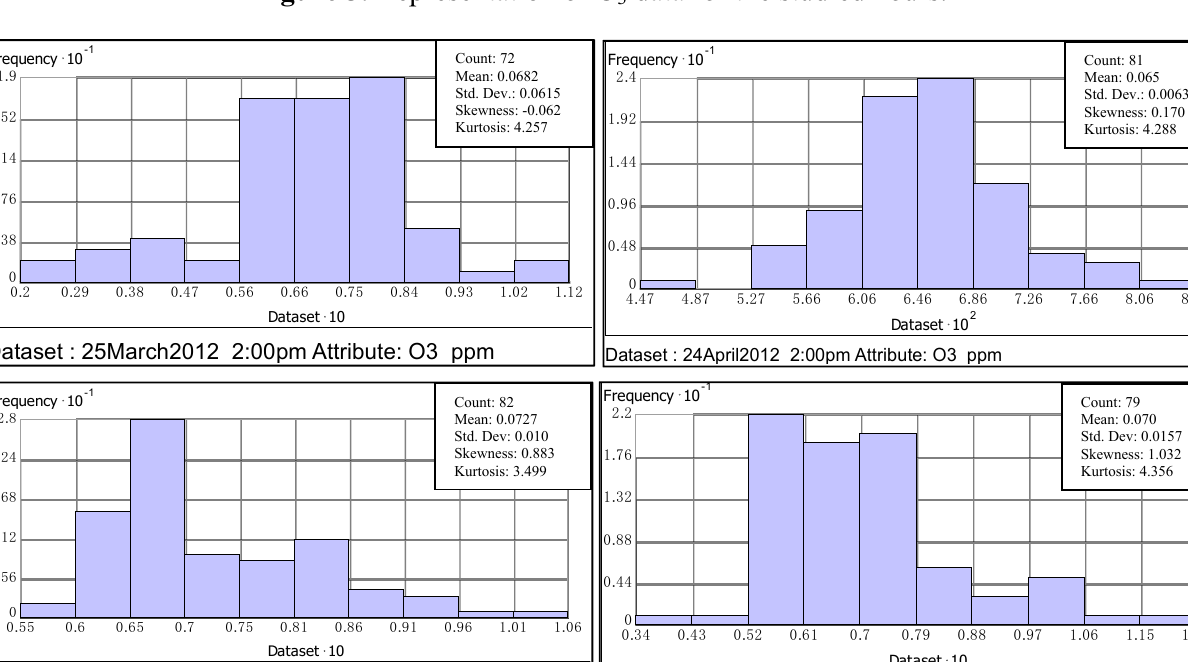
Figure 3. Representation of O